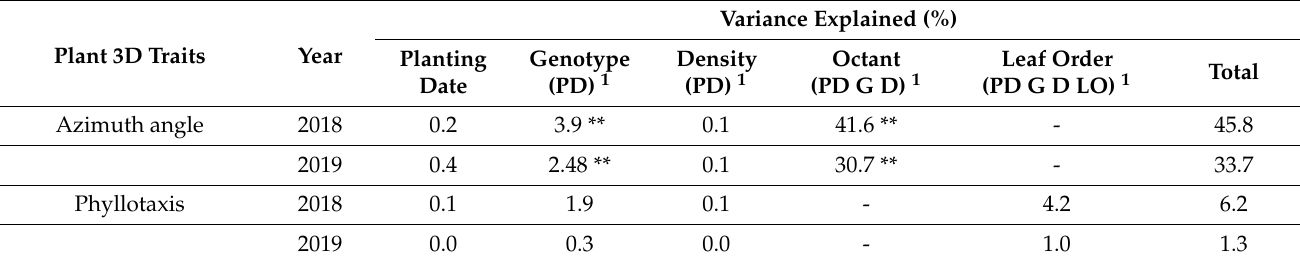
Table 4. Analysis of variance for leaf azimuth angle and phyllotaxis as affected by planting date, genotype, density, and octant or leaf order.